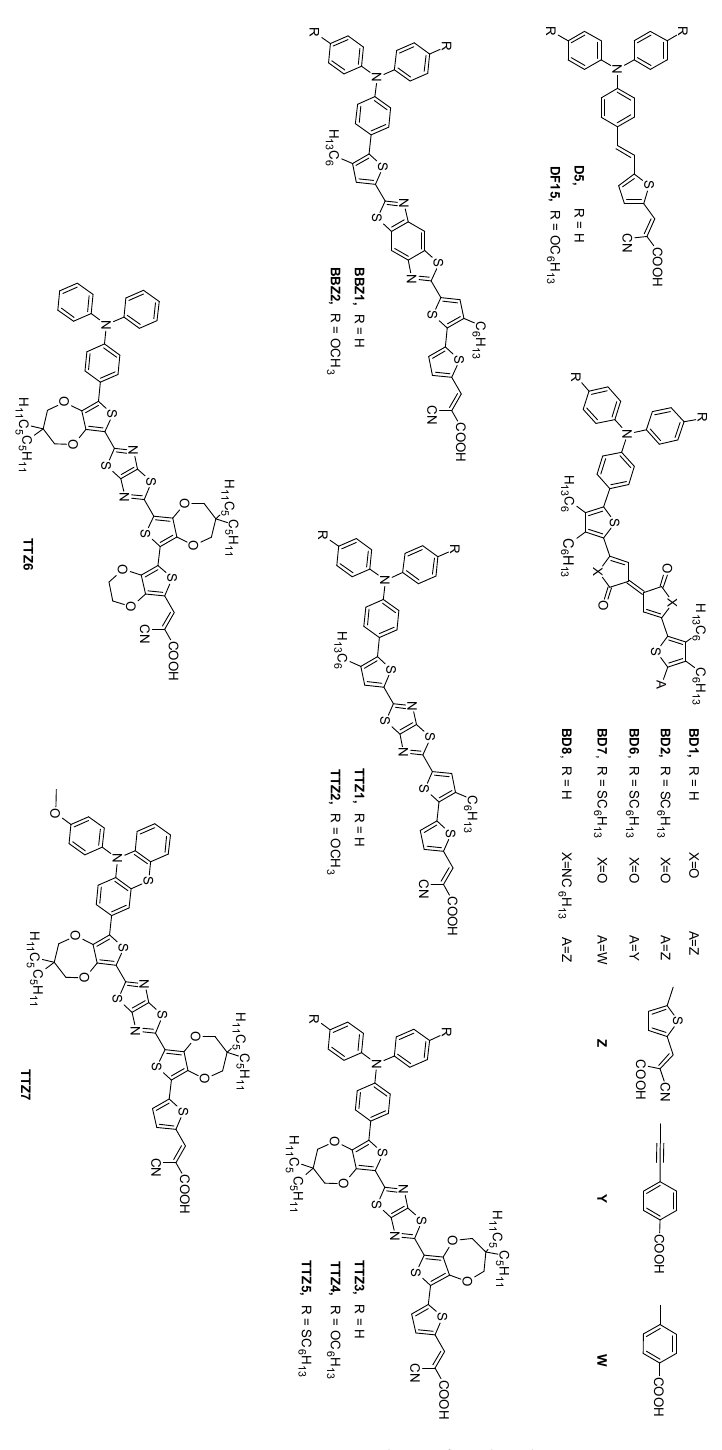
Figure 2. Investigated set of molecules.